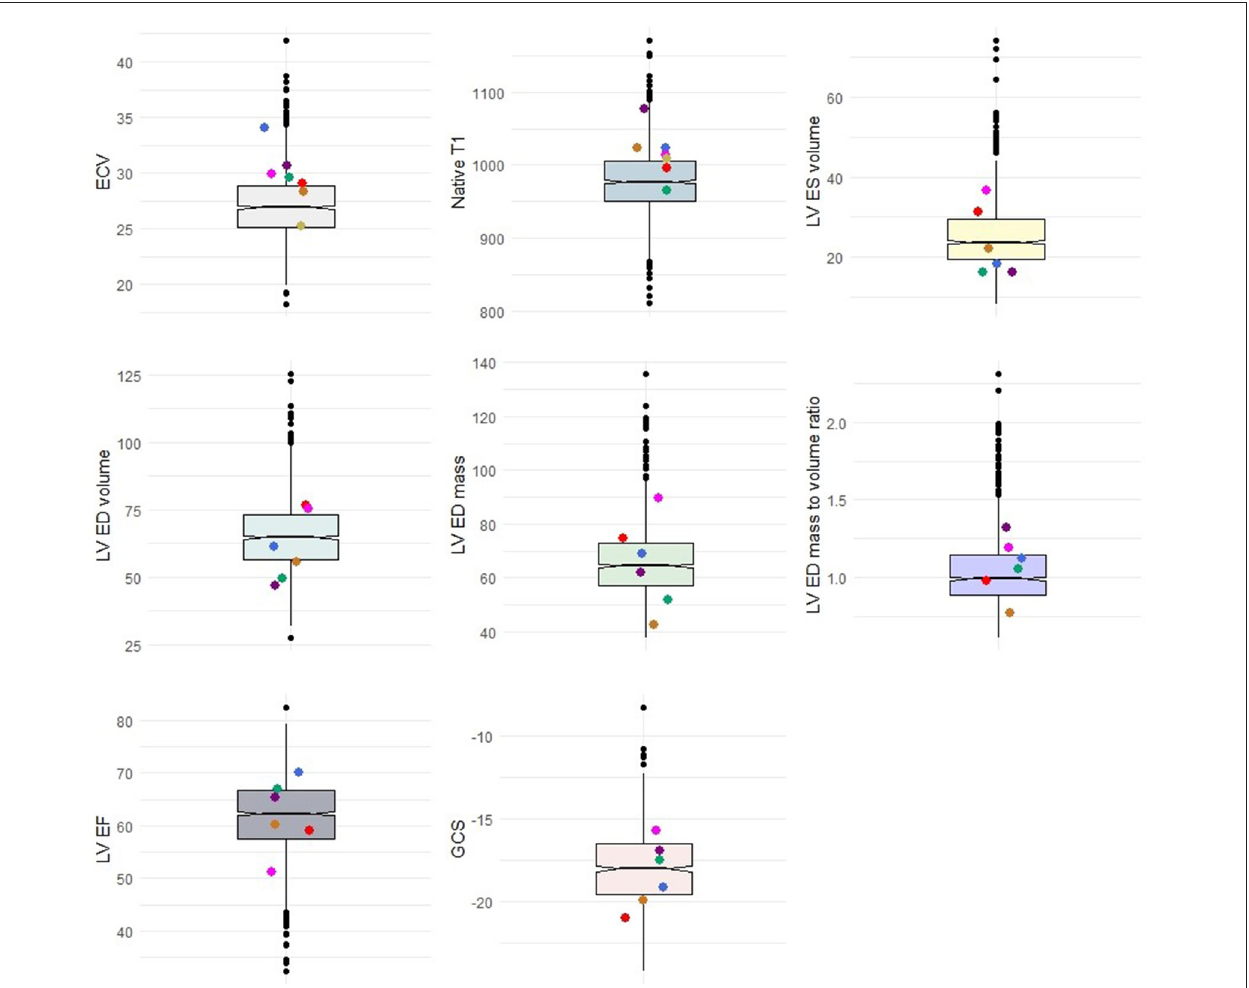
FIGURE 2 | Distribution of cases with P/LP variants or VUS + (colored dots) in comparison with the total population. Colored dots represent cases. Box plots represent the range of data within the 1st to 3rd quartile of variables with relation to the median in notches. ECV, Extracellular volume; LV, Left ventricle; ES, End-systolic; ED, End-diastolic; EF, Ejection fraction; GCS, Global circumferential strain.